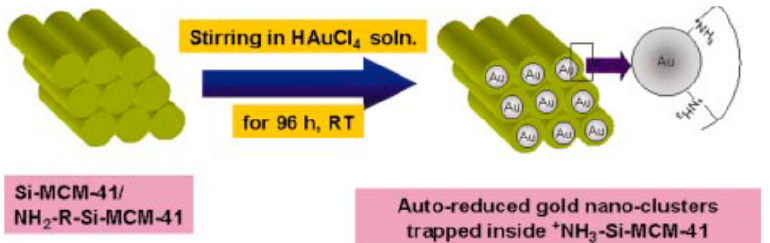
Figure 49. The probable structure of the NH 2 -MCM-41 material before and after immersion in HAuCl 4 solution. Reproduced with permission from [105]. Copyright 2001 Royal society of chemistry.